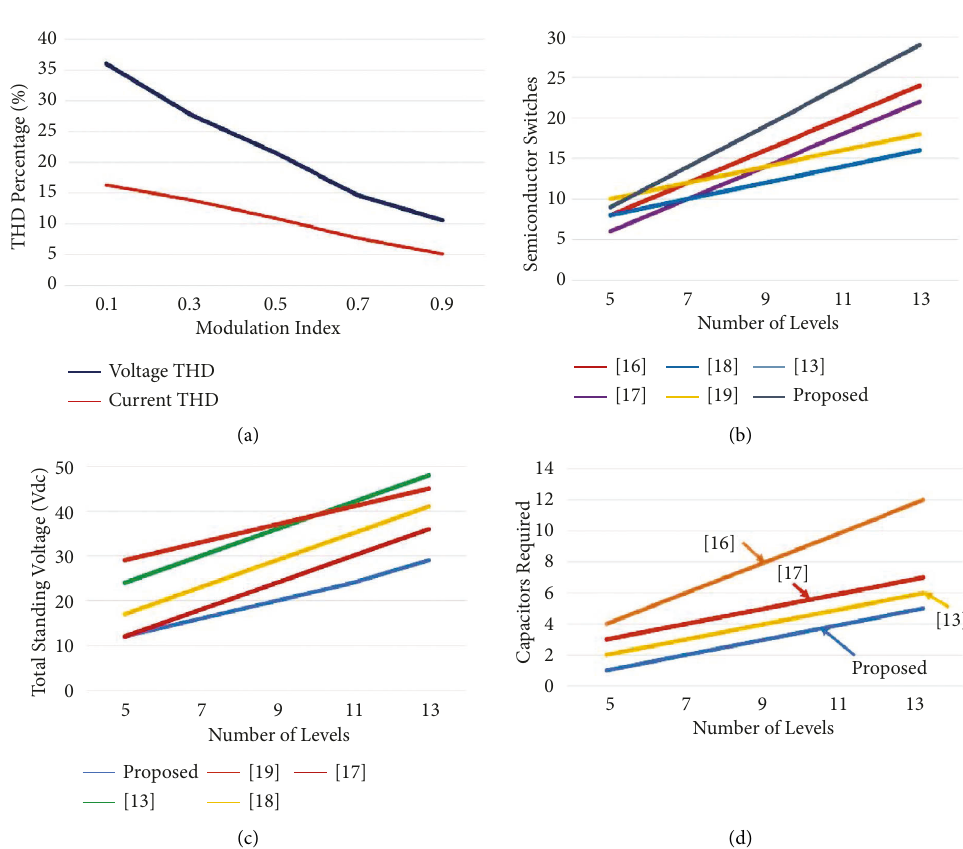
Figure 18: Comparison of expansions. (a) THD percentage, (b) semiconductor switches, (c) total standing voltage, and (d) capacitors